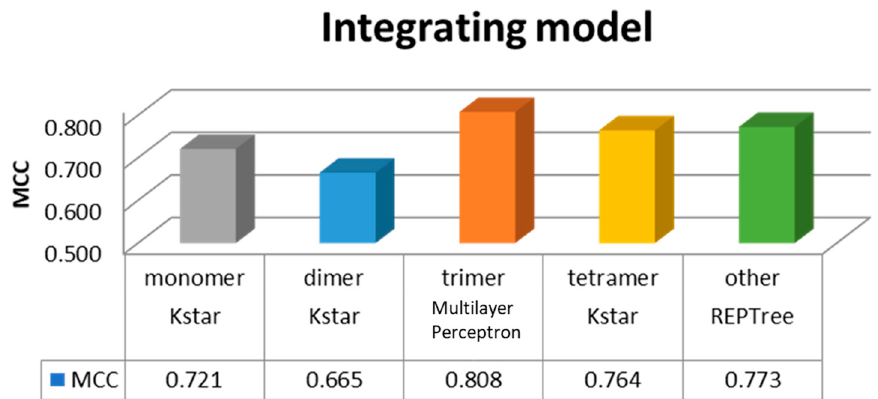
Figure 2. Different complexes and their best performance integrated module. MCC: Matthews correlation coefficient.